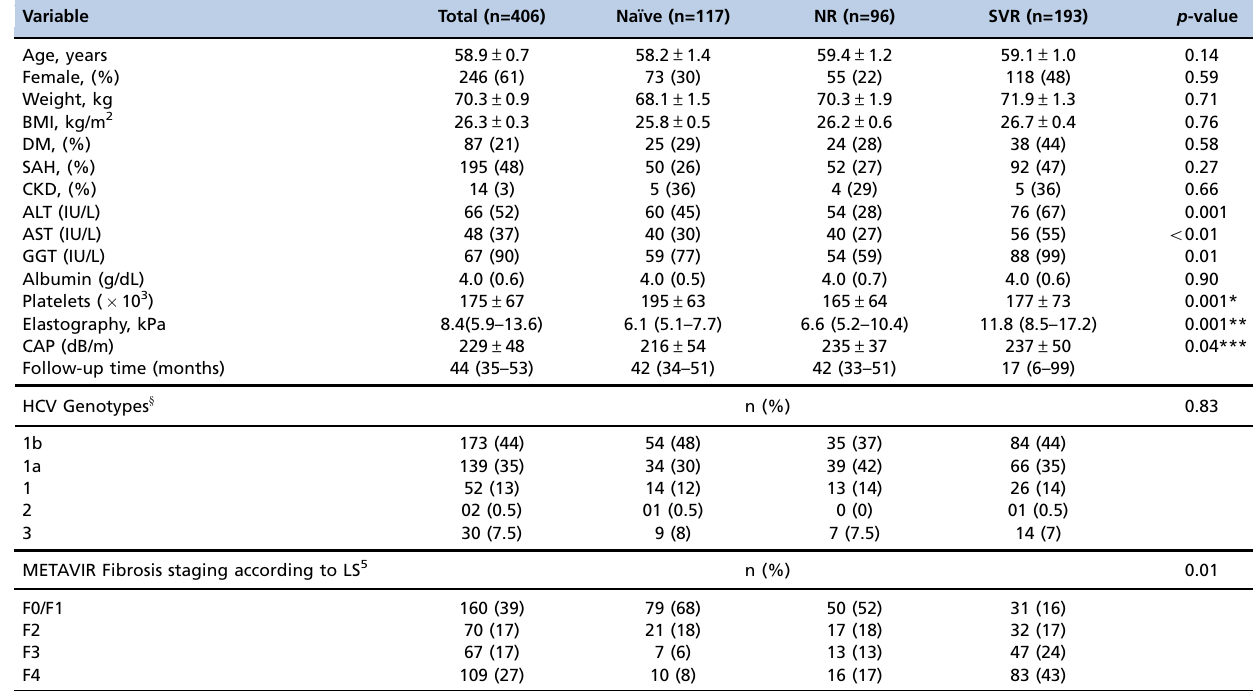
Table 1 - Baseline characteristics and comparative analysis of the HCV-infected naı¨ve, NR, and SVR groups (n=406). Variable Total (n=406)